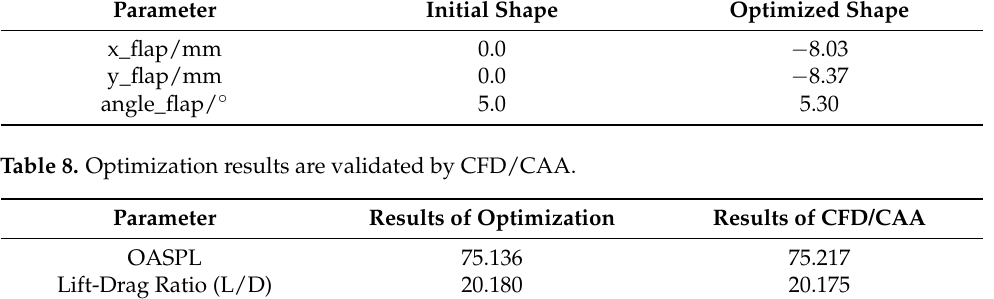
Table 8. Optimization results are validated by CFD/CAA.